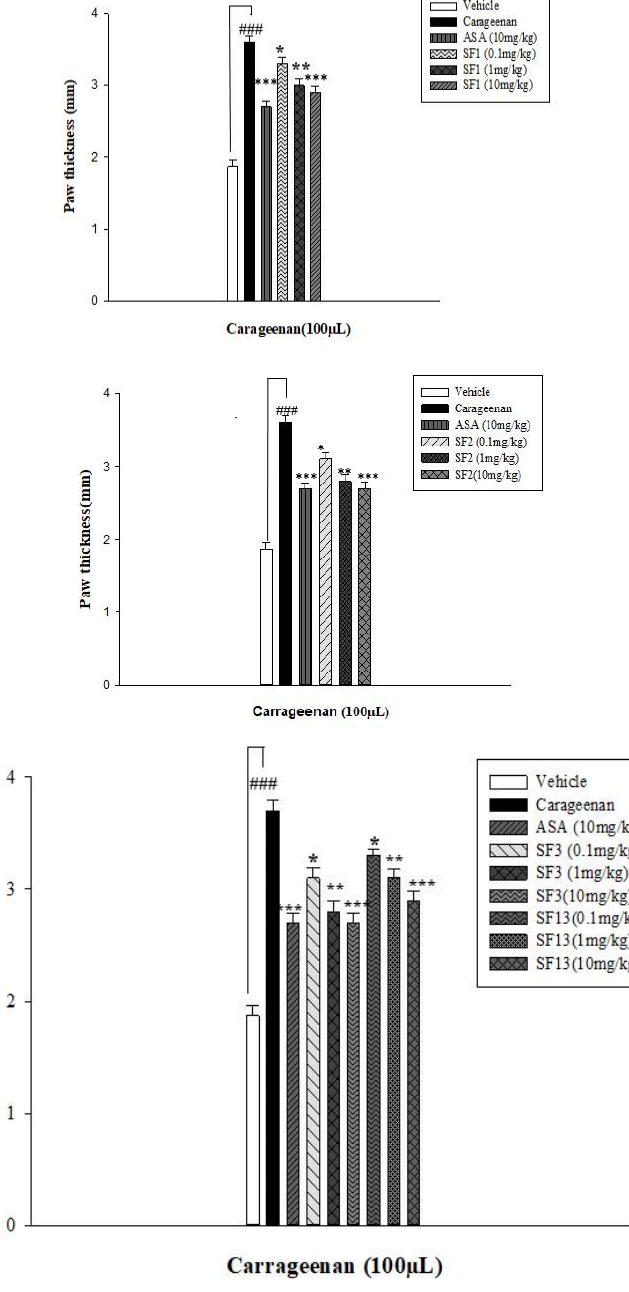
Figure 9. The dose response of synthesized compounds at 0.1, 1 and 10 mg / kg i.p. carrageenan-induced (100 µ L / paw) acute inflammatory model in mice ( n = 5). To determine the e ff ect of pretreatment on carrageenan-induced paw edema, the following e ff ects were measured 4 h post carrageenan injection. The data are given as mean ± SEM (standard error of the mean), * p < 0.05, ** p < 0.01, *** p < 0.001 and ### indicates significant di ff erences from the carrageenan-treated